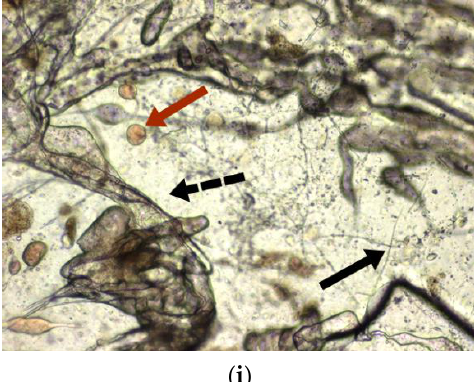
Figure 6. Morphology of Ganoderma cultures on lignocellulosic substrate (wheat straws) and polypropylene embedded with bacterial spores. ( a ) Hyphae network of Ganoderma (black arrow) and wheat straws (white arrow) (10 × ); ( b ) Hyphal network of Ganoderma (black arrow) and polypropylene (black dotted arrow) (10 × ); ( c ) Wheat straws (white arrow) and hyphae network of Ganoderma (black arrow) (10×); ( d ) Wheat straws (white arrow) covered by hyphae network of Ganoderma (black arrow) ( 10×); ( e ) A wheat straw (white arrow), network of fungal filaments of Ganoderma (black arrow), propylene piece (black dotted arrow) (10×); ( f ) Polypropylene piece (black dotted arrow) covered by hyphae network of Ganoderma (black arrow) (10×); ( g ) A wheat straw (white arrow) and network of fungal filaments of Ganoderma (black arrow) (10 × ); ( h ) Small polypropylene piece (black dotted arrow) covered by fungal filaments of Ganoderma (black arrow) (10×); ( i ) Polypropylene (dotted black arrow), agglomerations of Bacillus spores. (red arrow) and fungal filaments from Ganoderma mycelium (black arrow) (10×).